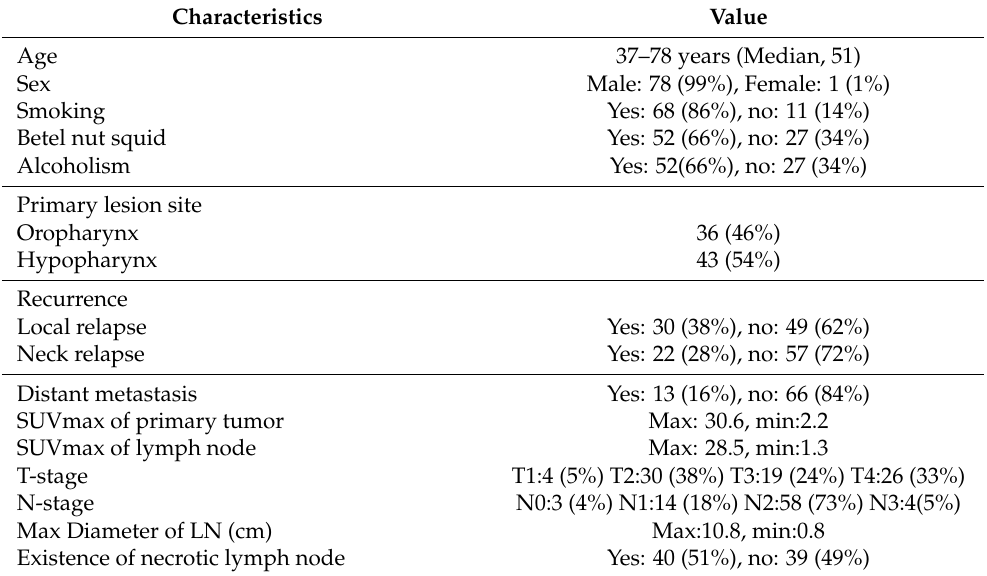
Table 1. Patient Characteristics (Total =